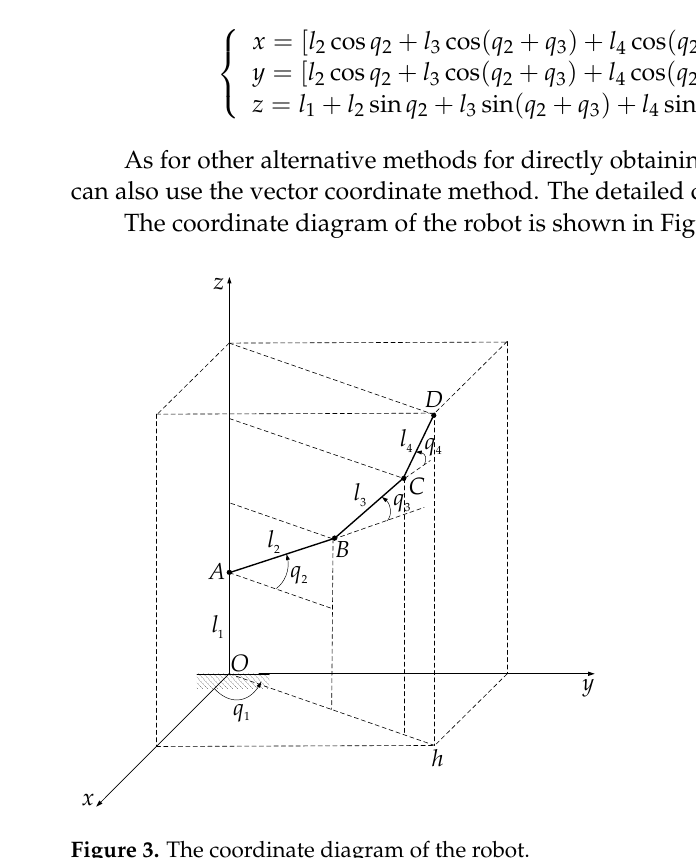
Figure 3. The coordinate diagram of the robot.